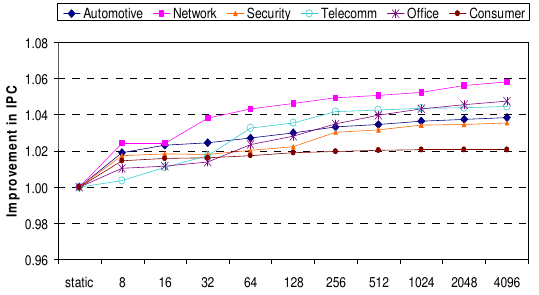
Figure 7. IPC results for a bimodal branch predictor relative to IPC results of a static predictor using different BHT